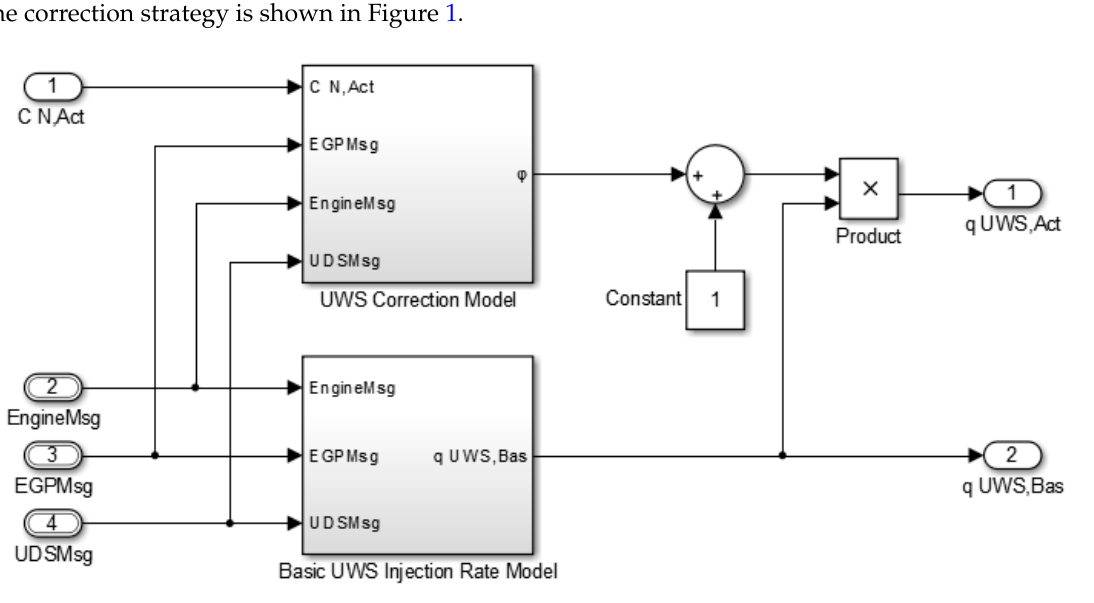
Figure 1. The correction strategy model. UWS: urea water solution.